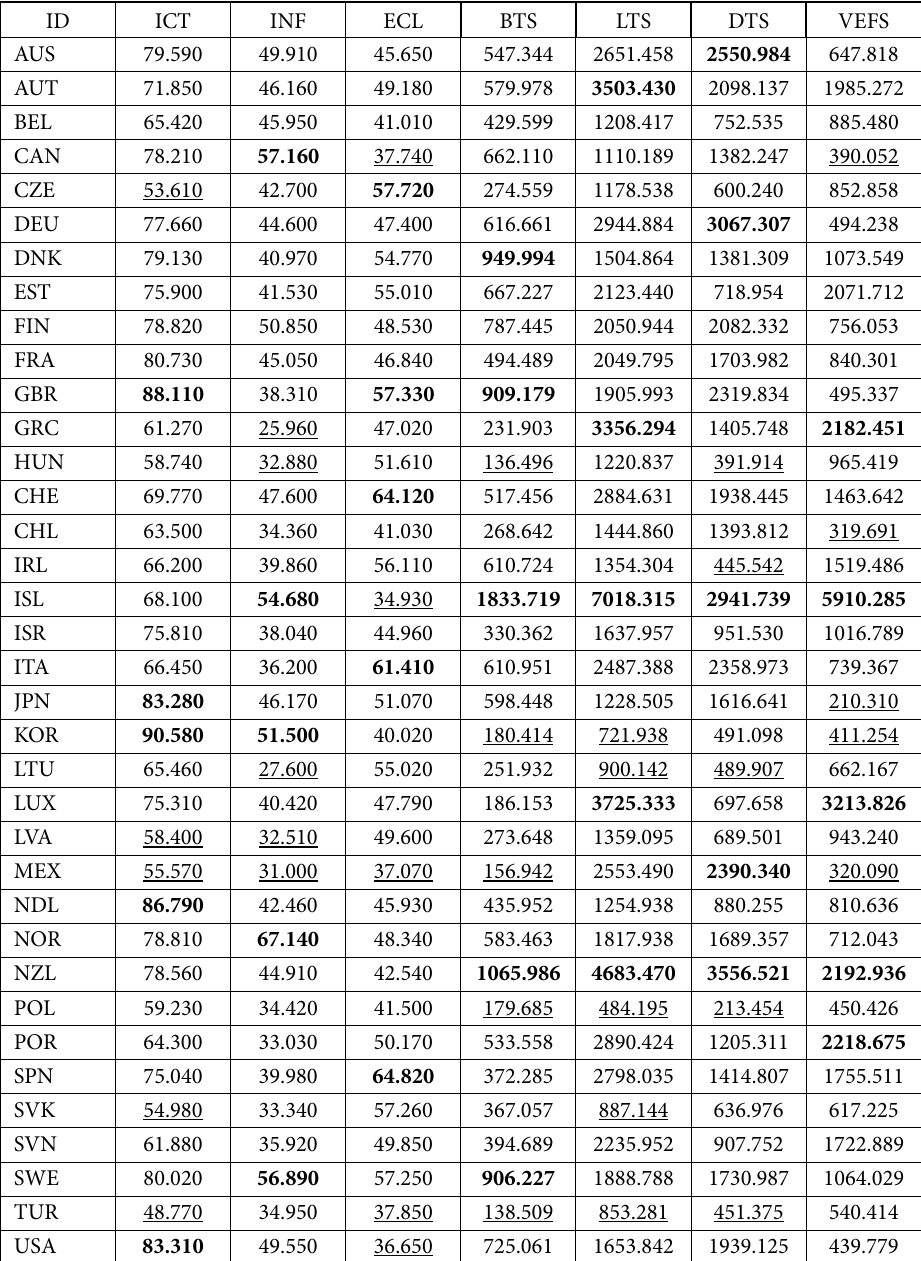
Table 2. Mean values for individual